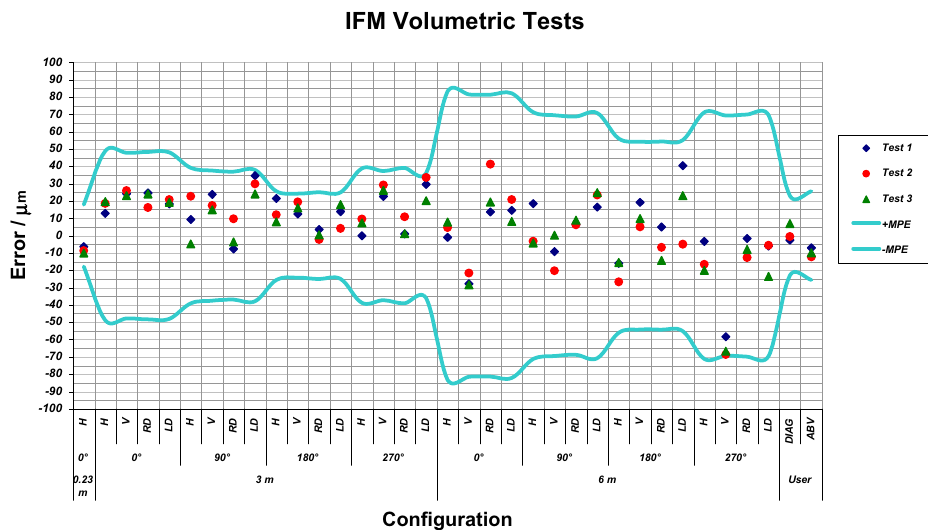
Fig. 8. Length measurement system test results (interferometer mode). ADM Volumetric Tests